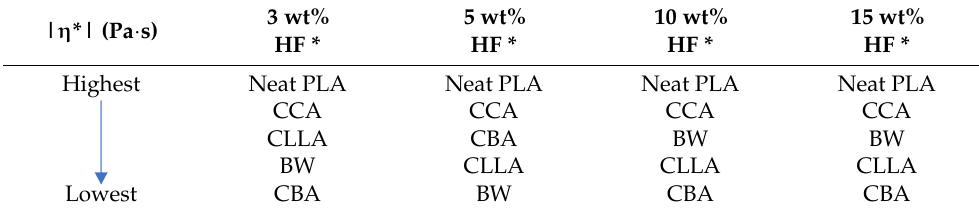
Table 4. Complex viscosity (| η *|) of PLA–wax blends in the high-frequency